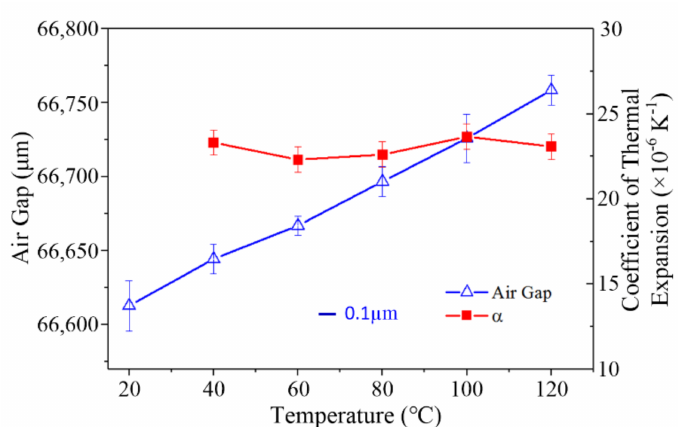
Figure 9. CTE measurement of the aluminum truss structure. The air gap is the distance between the two lenses fixed on the sample. It increased with an increase in the temperature. The blue scale bar represents 0.1 µ m in length of the measurement error of the air gap. “ α ” is the CTE of the